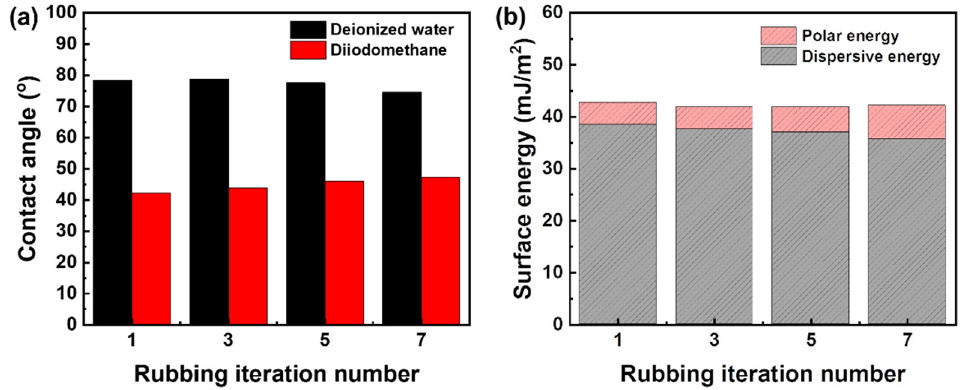
Figure 4. ( a ) Contact angles and ( b ) surface energies of solution-derived ZnO films as a function of rubbing iteration number.